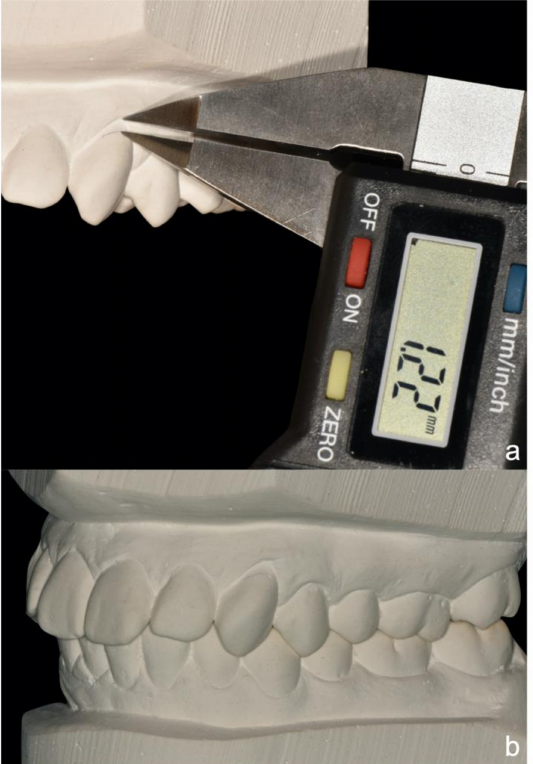
Figure 2. Gingival recession (GR) on plaster model. ( a )—measurement of GR on tooth 23 with digital caliper; ( b )—good quality of the plaster